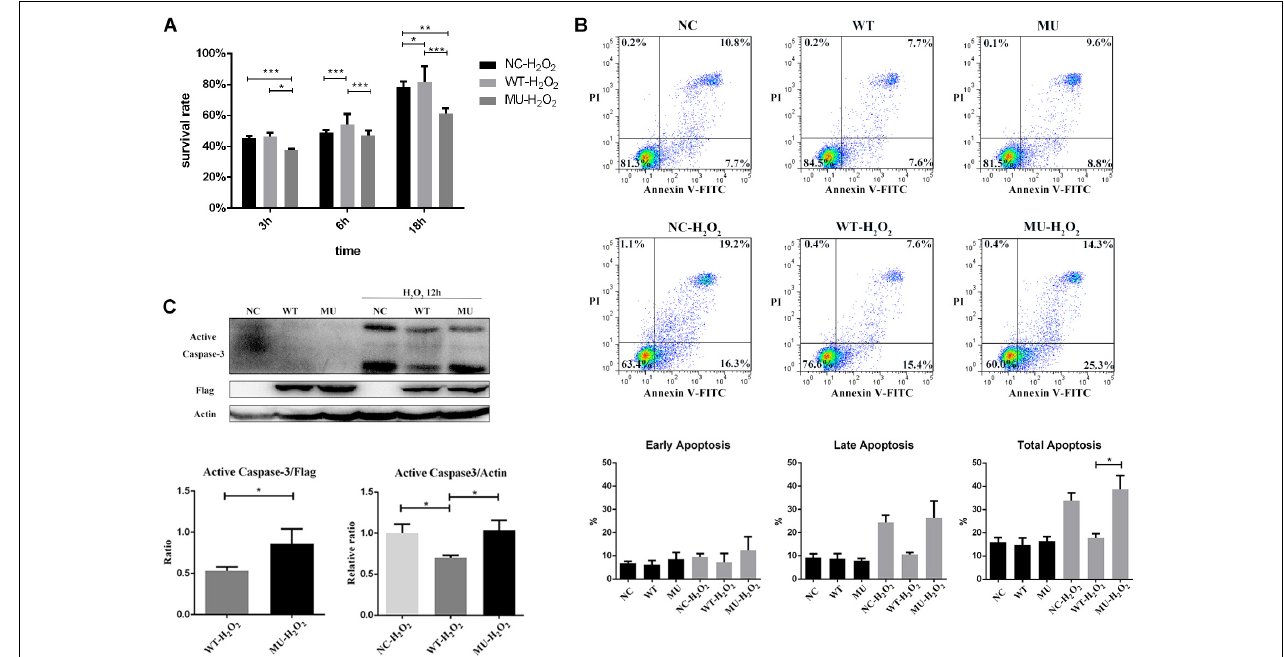
FIGURE 5 | Cell survival was decreased and apoptosis was increased in cells overexpressing mutant COL6A3 . (A) Cell viability of un-transfected, WT, and MU cells in response to H 2 O 2 stimulation (200 µ M) for 3, 6, and 18 h, respectively, as determined by CCK-8 assay. For cell viability comparisons after 6 h treatment with homoscedasticity, the P -values were calculated by one-way ANOVA test, followed by Bonferroni test. For cell viability comparisons after 3 h and 18 h treatment with heteroscedasticity, the P -values were calculated through Tamhane’s T2 test. (B) Representative scattergram of apoptotic HCECs. The un-transfected, WT, and MU groups stimulated or not stimulated with H 2 O 2 for 6 h were assessed for apoptosis through flow cytometry based on Annexin V/propidium iodide (PI) double staining. The percentage of early/late apoptotic cells (%) below in each individual group was calculated from three independent experiments (WT vs MU in total apoptosis with H 2 O 2 stimulation: P = 0.032). The P -values were calculated by one-way ANOVA test, followed by Bonferroni test. (C) Detection of apoptosis by caspase-3 activation. Cells treated with 200 µ M of H 2 O 2 for 12 h were harvested and cell lysates were prepared for western blotting to detect the levels of active caspase-3. Beta-actin and FLAG was used as the loading control. The column graph showed quantification of active caspase-3 protein from western blotting bands; values were the average with standard deviation obtained from three independent experiments (Active Caspase-3/FLAG: WT-H 2 O 2 vs MU-H 2 O 2 : P = 0.042; Active Caspase-3/Actin: WT-H 2 O 2 vs un-transfected-H 2 O 2 : P = 0.030; WT-H 2 O 2 vs MU-H 2 O 2 : P = 0.026). The P -values were calculated through Student’s t-test and Tamhane’s T2 test. NC: the un-transfected HCECs. * P < 0.05, ** P < 0.01, *** P <